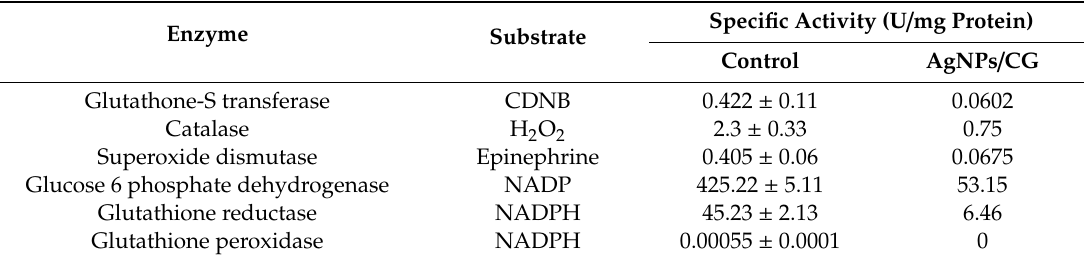
Table 2. Specific activities of antioxidant enzymes.